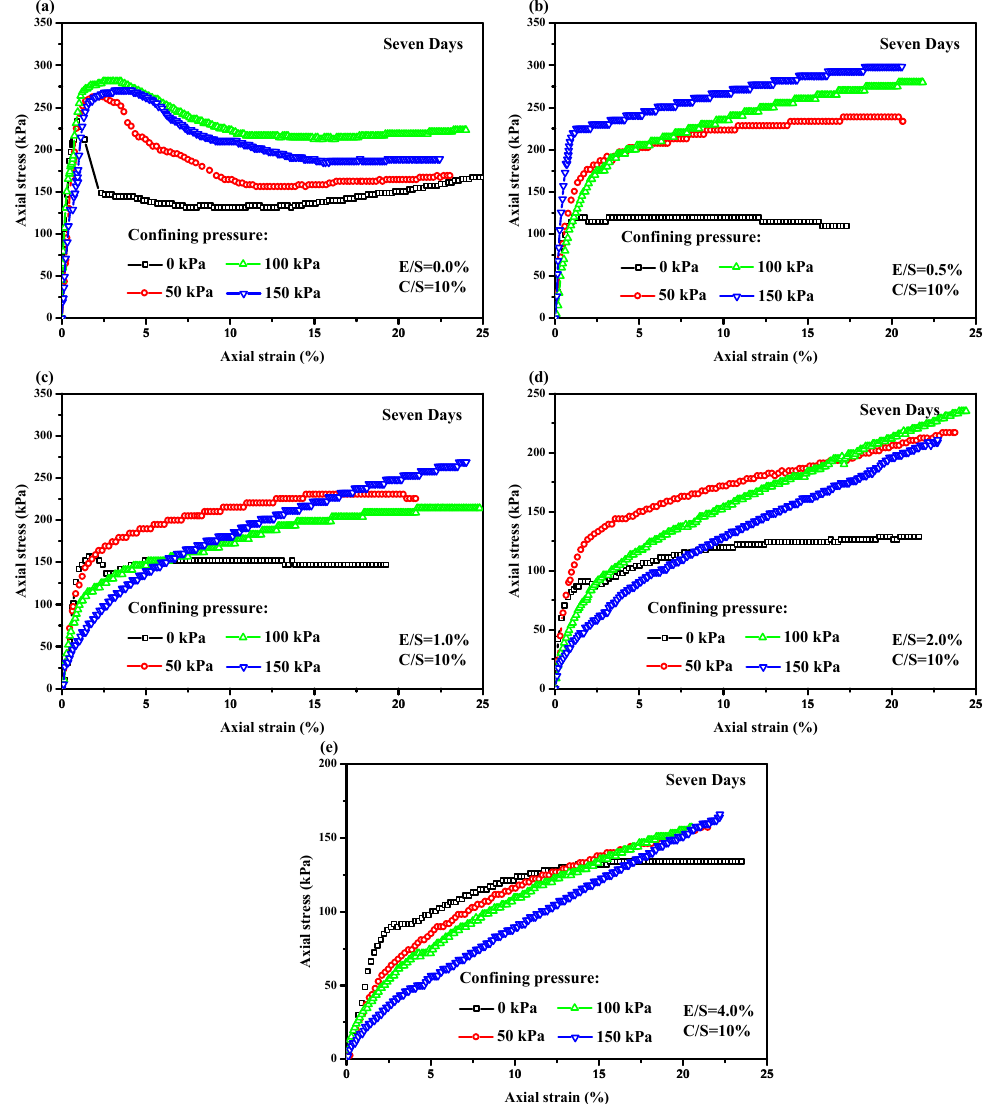
Figure 7. Axial stress and axial strain curves of EPS-cement lightweight clay with different confining pressures for seven days curing period with cement ratio 10% for all EPS ratios ( a ) 0%; ( b ) 0.5%; ( c ) 1.0%; ( d ) 2.0% and ( e ) 4.0%.